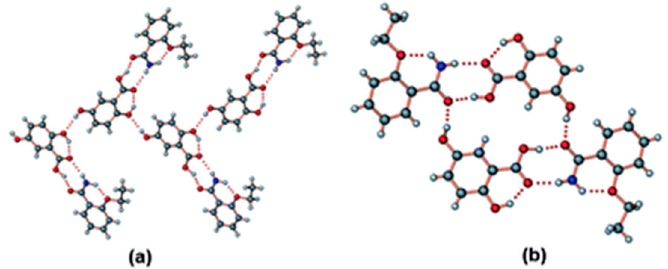
Figure 21. ( a ) A hydrogen bonded linear tape in form II crystal structure. ( b ) A hydrogen